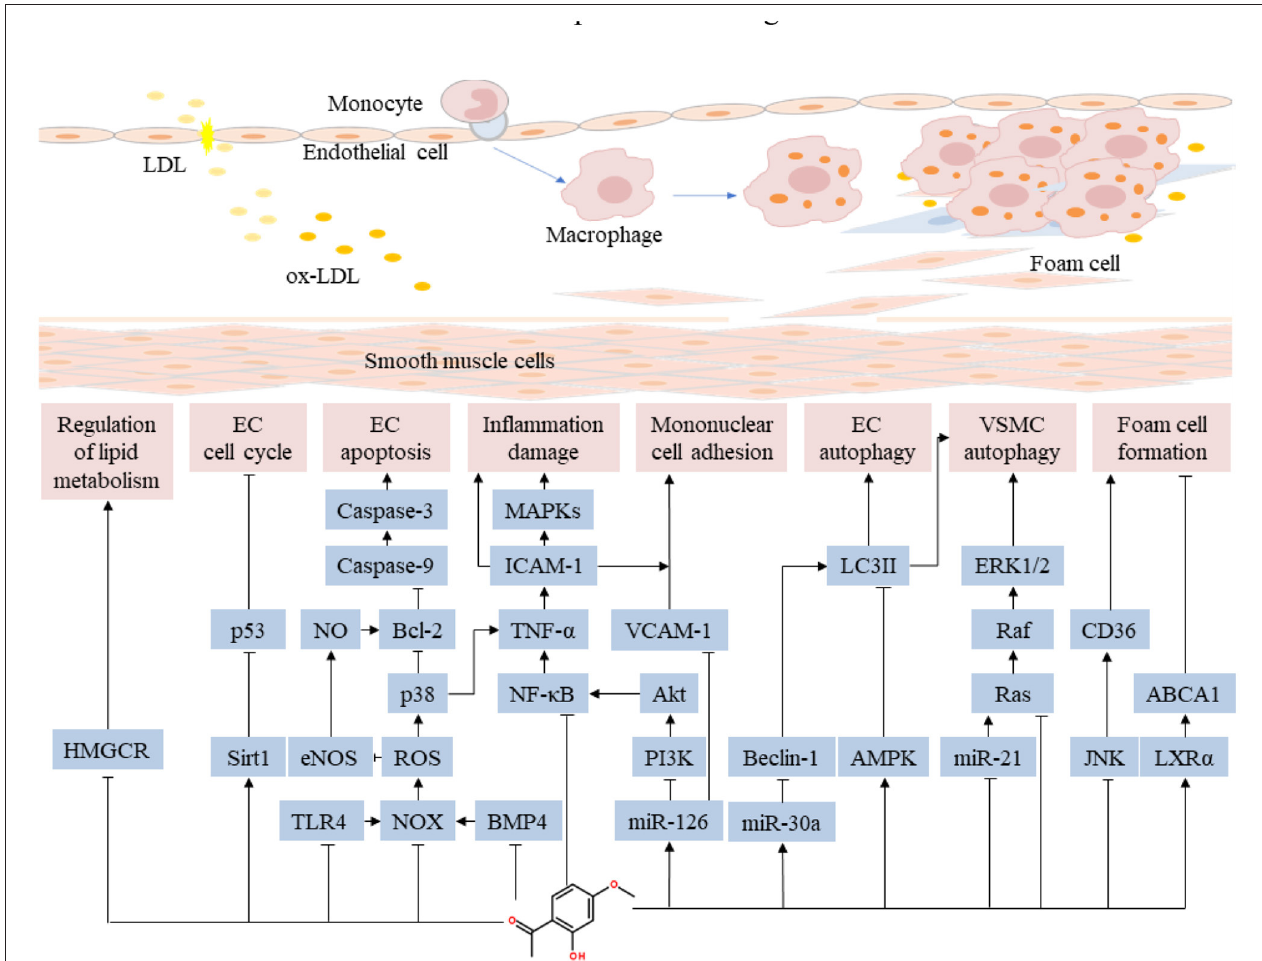
FIGURE 3 | Pharmacological mechanisms of paeonol on anti-inflammatory and regulating lipid metabolism in atherosclerotic cardiovascular disease. Paeonol confers anti-inflammatory effect by suppressing the release of inflammatory cytokines through a variety of pathways, inhibiting the monocyte adhesion and the proliferation of VSMCs. Paeonol regulates lipid metabolism by inhibiting lipid synthesis, enhancing the activity of lipase, and regulating the reverse transport process in macrophages. ABCA1, adenosine triphosphate-binding cassette transporter A1; JNK, c-Jun N-terminal kinase; EC, endothelial cell; eNOS, endothelial nitric oxide synthase; ERK, extracellular signal-regulated kinase; ICAM, intercellular adhesion molecule; LXR α , liver X receptor-alpha; MAPK, mitogen-activated protein kinase; NOX, nitrogen oxide; NO, nitrous oxide; NF- κ B, nuclear factor-kappa B; PI3K, phosphoinositide 3-kinase; ROS, reactive oxygen species; HMGCR, recombinant 3-hydroxy-3-methylglutaryl coenzyme A reductase; TLR, Toll-like receptor; TNF, tumor necrosis factor; VCAM, vascular cell adhesion molecule; VSMC, vascular smooth muscle